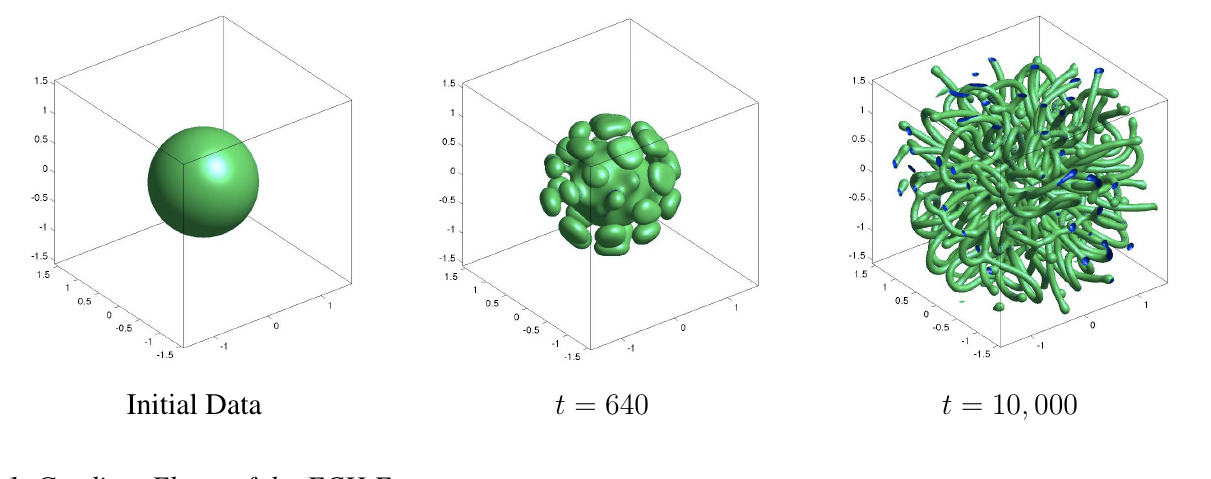
Figure 4. Time evolution of a spherical solvent distribution, here (cid:15) = 0 . 01 with parameters E = 1 , η = (cid:15), η = 4 (cid:15) , and well tilt τ = 0 . 4 . The large solid sphere is unstable and b h m − generates multiple end-cap structures, which elongate and grow into a pore network. The end-state, at t = 10 , 000 , is an equilbria of the